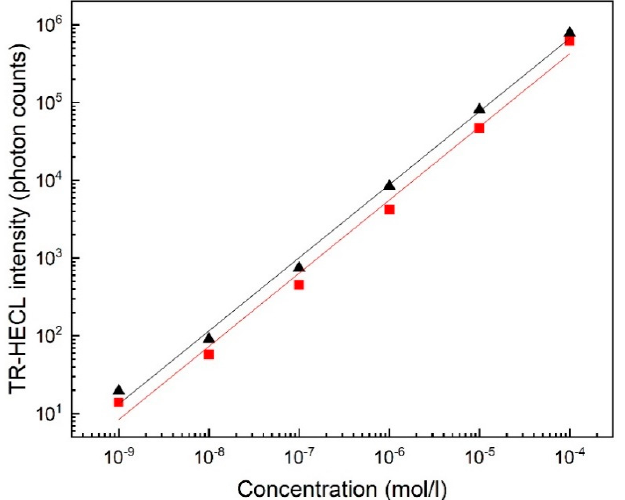
Figure 5. Calibration curve Tb(III)-1 with 0.01 NaN 3 in 0.05 M Na 2 B 4 O 7 , 0.1 M Na 2 SO 4 . RS electrode. EC-CB (triangles), PS-CB (squares). Conditions: 2000 excitation pulses. Pulse charge 31.5 µ C, voltage − 55 V, frequency 50 Hz, delay 160 µ s and gate 4 ms. Interference filter (550 ± 10 nm).